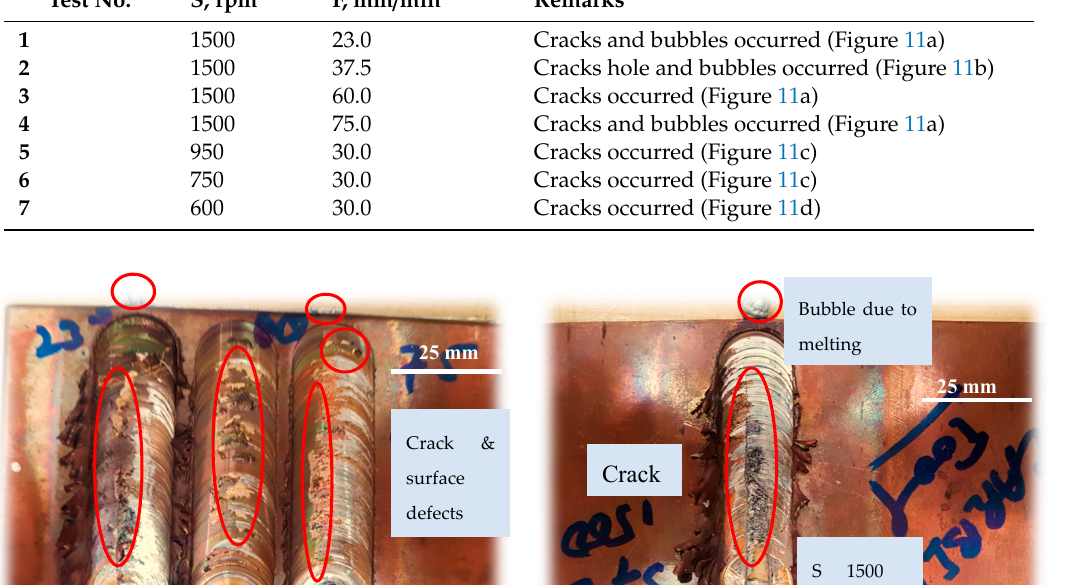
Table 9. Experiments for fabricating Cu -2219Al lap joint using WC square-pin (T D : 20 s). Test No.